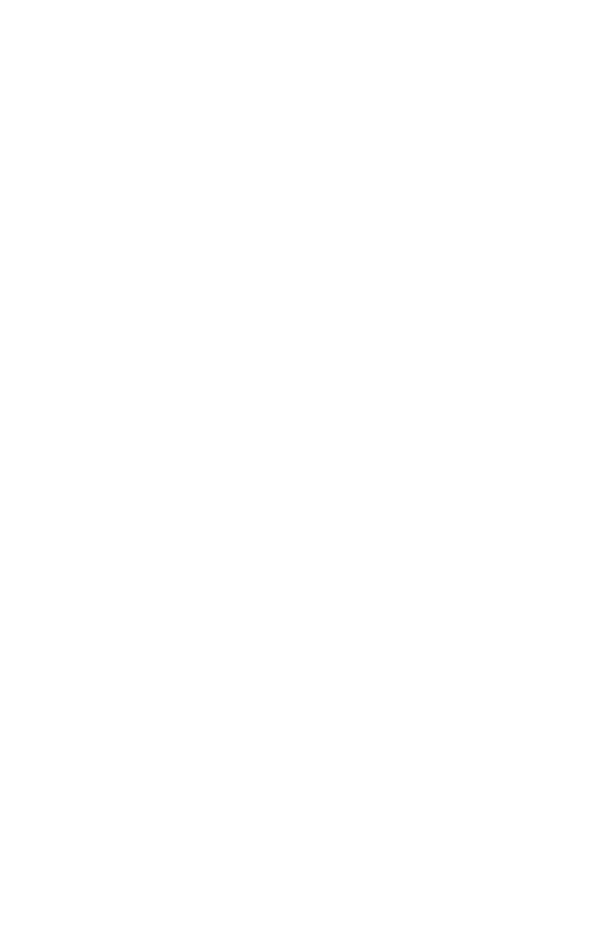
Table 4. The characteristics of the cases receiving